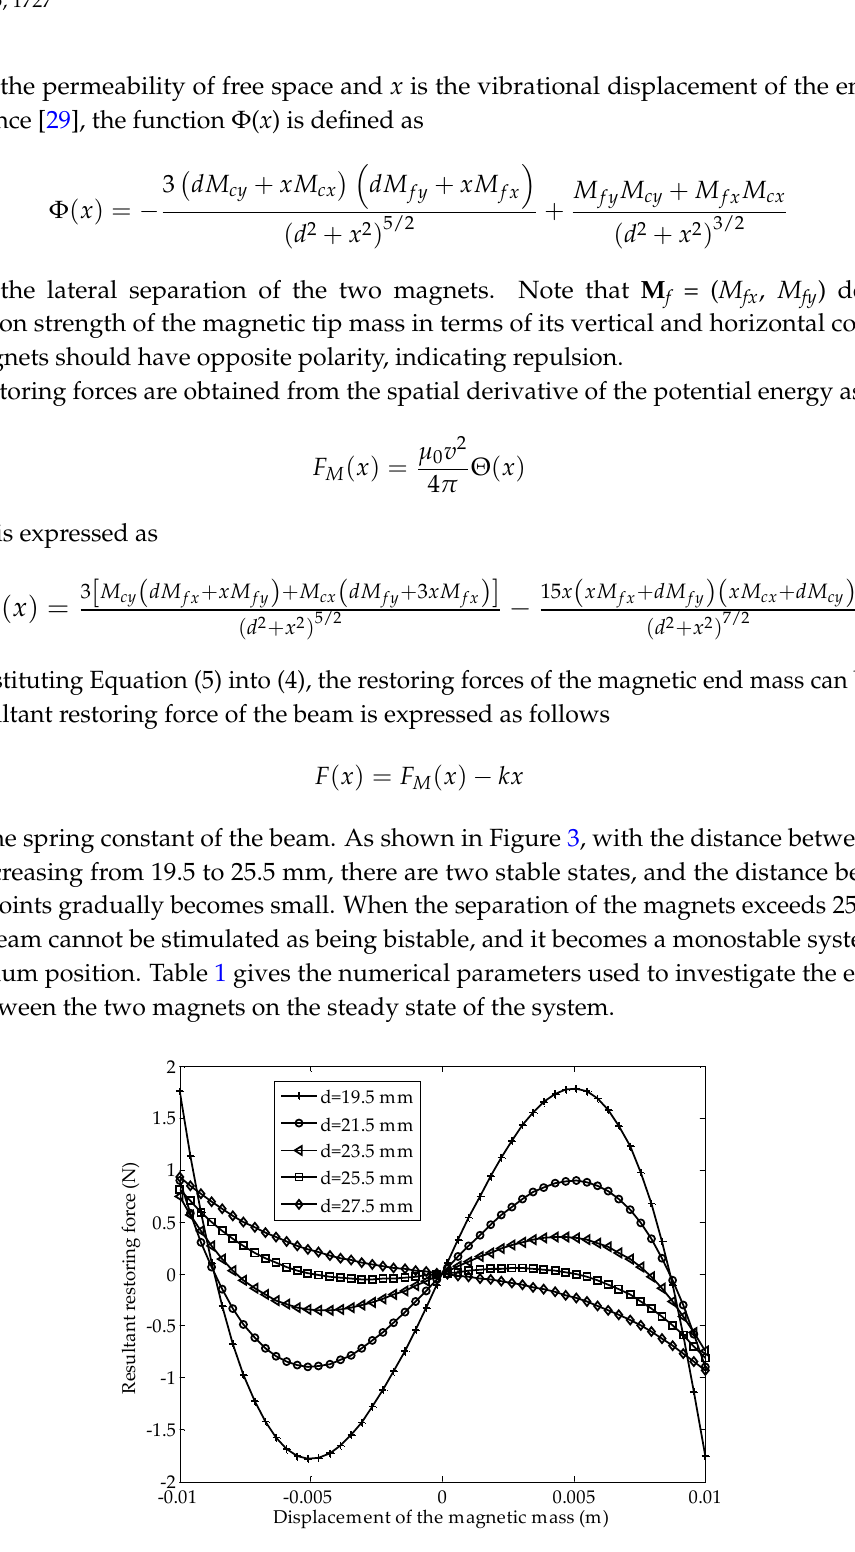
Figure 3. Resultant force versus the distance between the two magnets.